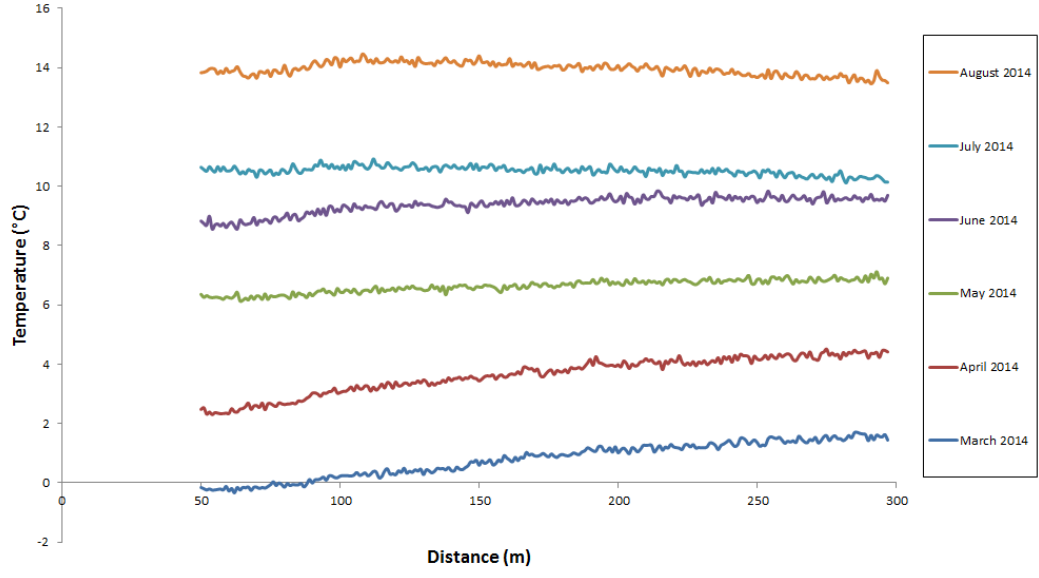
Figure 7. Seabed sediment temperatures measured from March 2014 to August 2014 in Liito-oravankatu. Temperatures increase after the winter months.